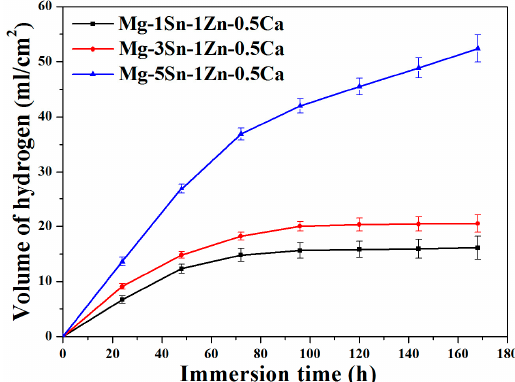
Figure 7. Hydrogen evolution of Mg − xSn − 1Zn − 0.5Ca (x = 1, 3 and 5 wt.%) alloys in the Hank’s solution for 7 days.